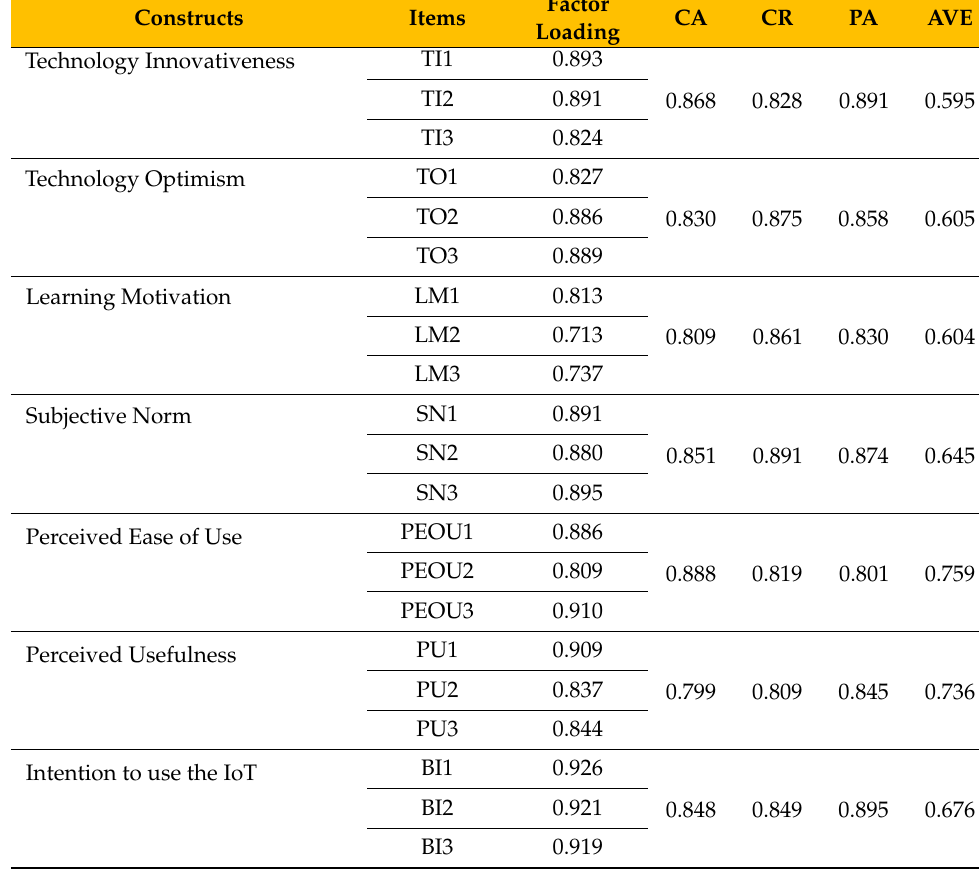
Table 3. Convergent validity results.